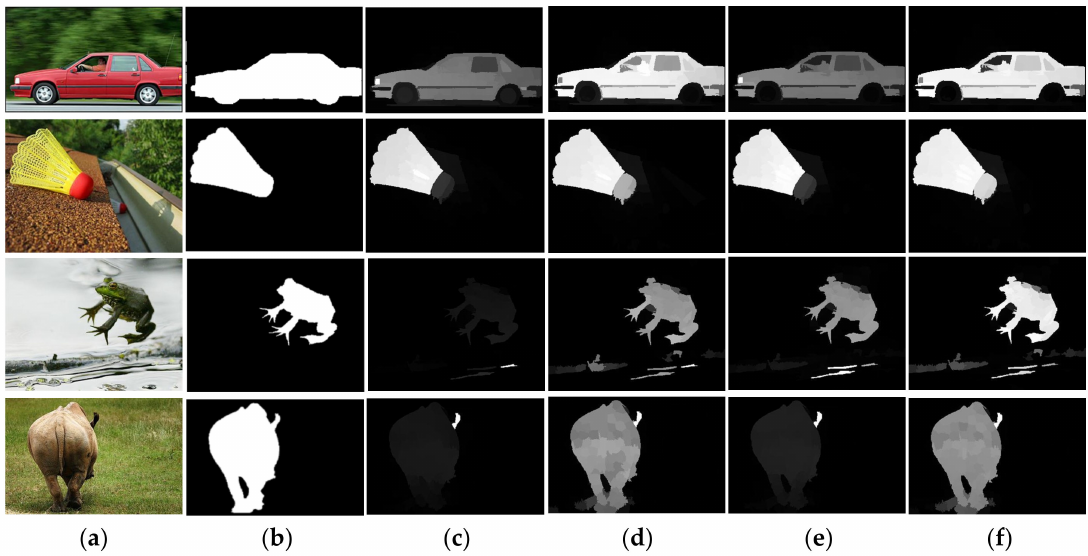
Figure 2. Visual comparisons of different graph-based methods. ( a ) Original image; ( b ) Ground truth; ( c ) Saliency maps produced by 2-layer neighborhood graph; ( d ) Saliency maps produced by 2-layer neighborhood graph with nonlocal connections; ( e ) Saliency maps produced by 2-layer sparse graph; ( f ) Saliency maps produced by 2-layer sparse graph with the nonlocal connections.